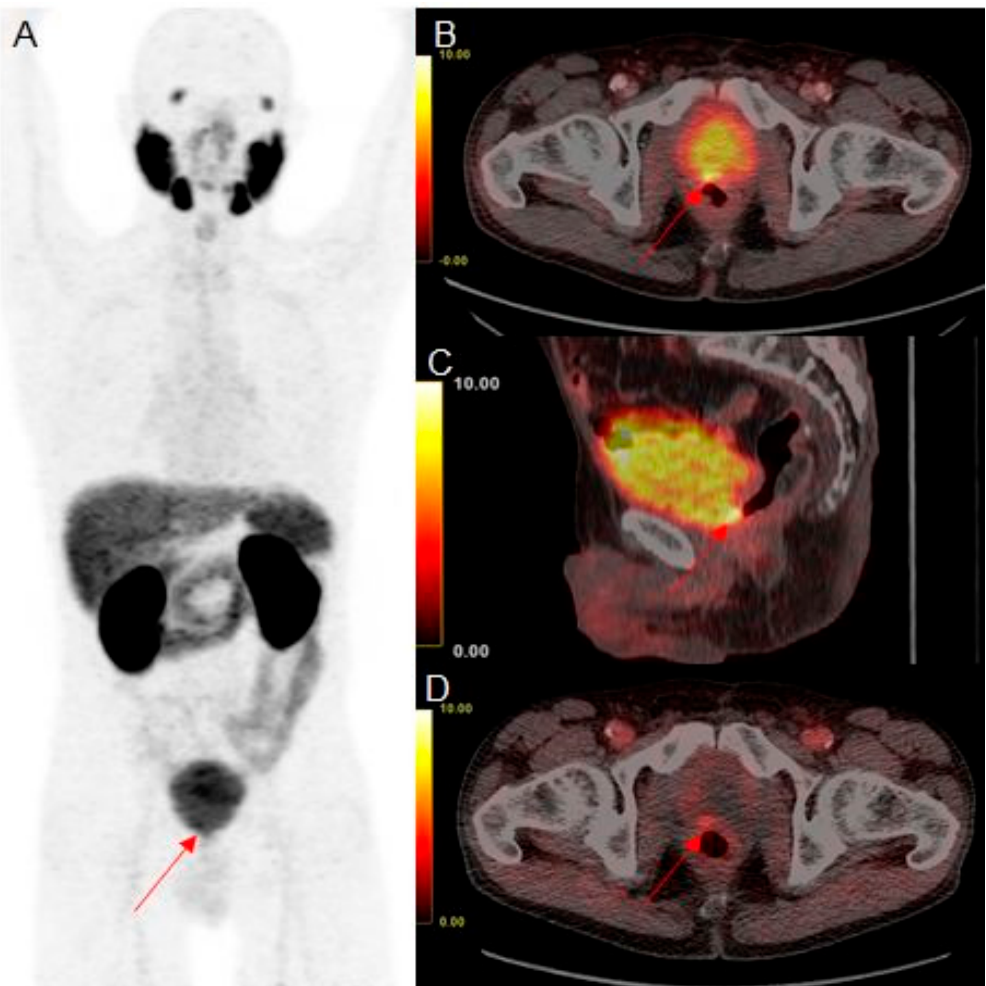
Figure 1. Example of an equivocal finding in the prostate fossa in 68Ga-PSMA-11 PET/CT scans 60 min p.i. with maximum intensity projection ( A ), fused axial ( B ), and fused sagittal ( C ) slices, and positive findings in the early fused axial ( D ) slices of a prostate cancer patient with biochemical recurrence after radical prostatectomy and salvage radiation therapy (PSA, 0.46 ng/mL). Intense focal uptake is the present paramedian at the posterior surface of the urinary bladder (red arrowhead). A clear distinction between local recurrence and urinary activity within the bladder is not possible in late images (SUVmax of focal uptake, 8.9; SUVmax of urinary bladder, 8.9). However, focal tracer accumulation is clearly visible in the early images (SUVmax of focal uptake, 3.3; SUVmax of urinary bladder, 2.7).